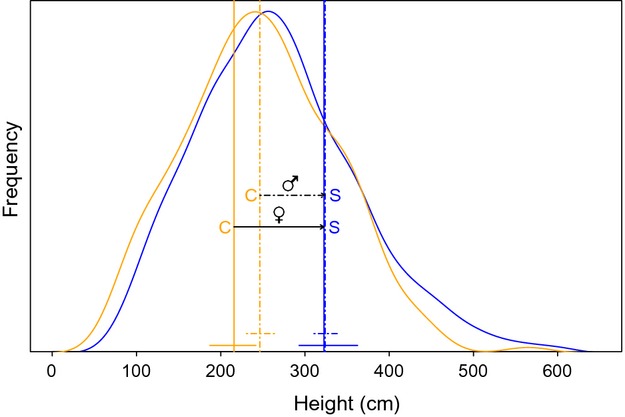
Comparison of height density distribution and threshold size (height) for first reproduction between Pinus pinaster progenies of trees either selected (S) or not selected (C, control) for timber production after one generation. Bell-shaped lines represent height probability distribution at age 10 years. Control group, orange lines; selected group, blue lines. Vertical lines represent threshold sizes for reproduction. Solid line, female function; dashed line, male function. 95% credible intervals for threshold sizes are represented by horizontal lines. Arrows show changes in threshold size for reproduction in male and female function due to selection. Control group, left; selected group, right.